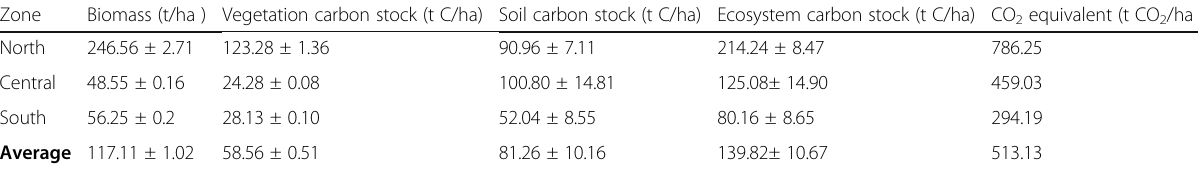
Table 4 Zone wise Biomass, Vegetation carbon stock, Soil carbon stock, Ecosystem carbon stock, CO 2 equivalent